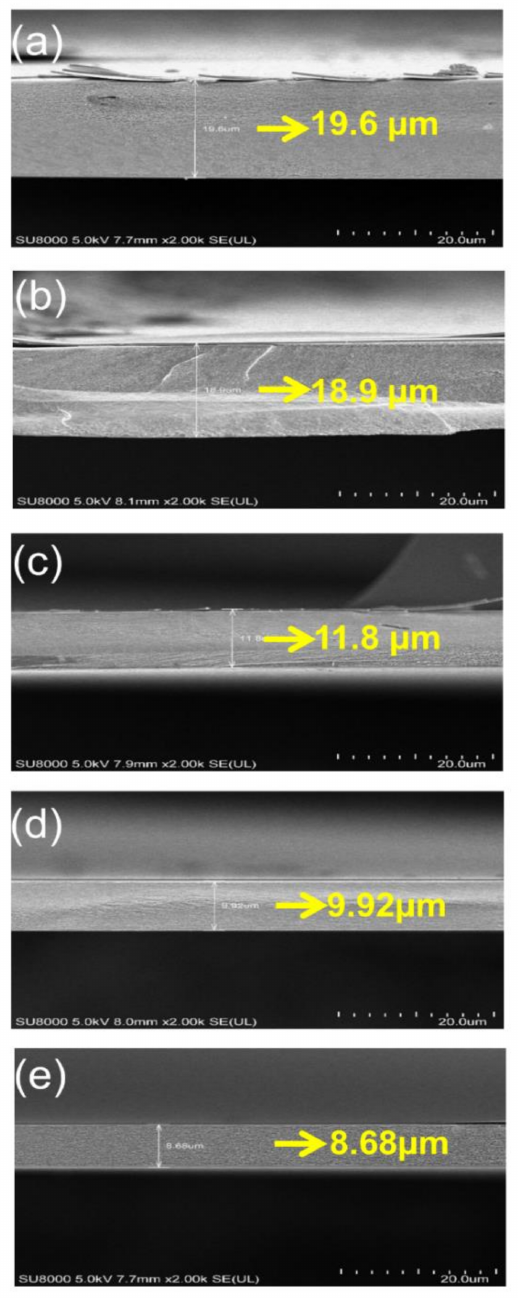
Figure 4. SEM image of the PI film after coating the inorganic barrier layer, SiO 2 and SiNx, according to the PI spin-coating conditions: ( a ) 2000 rpm, 60 s; ( b ) 2000 rpm, 120 s; ( c ) 3000 rpm, 120 s; ( d ) 4000 rpm, 120 s and ( e ) 5000 rpm 120